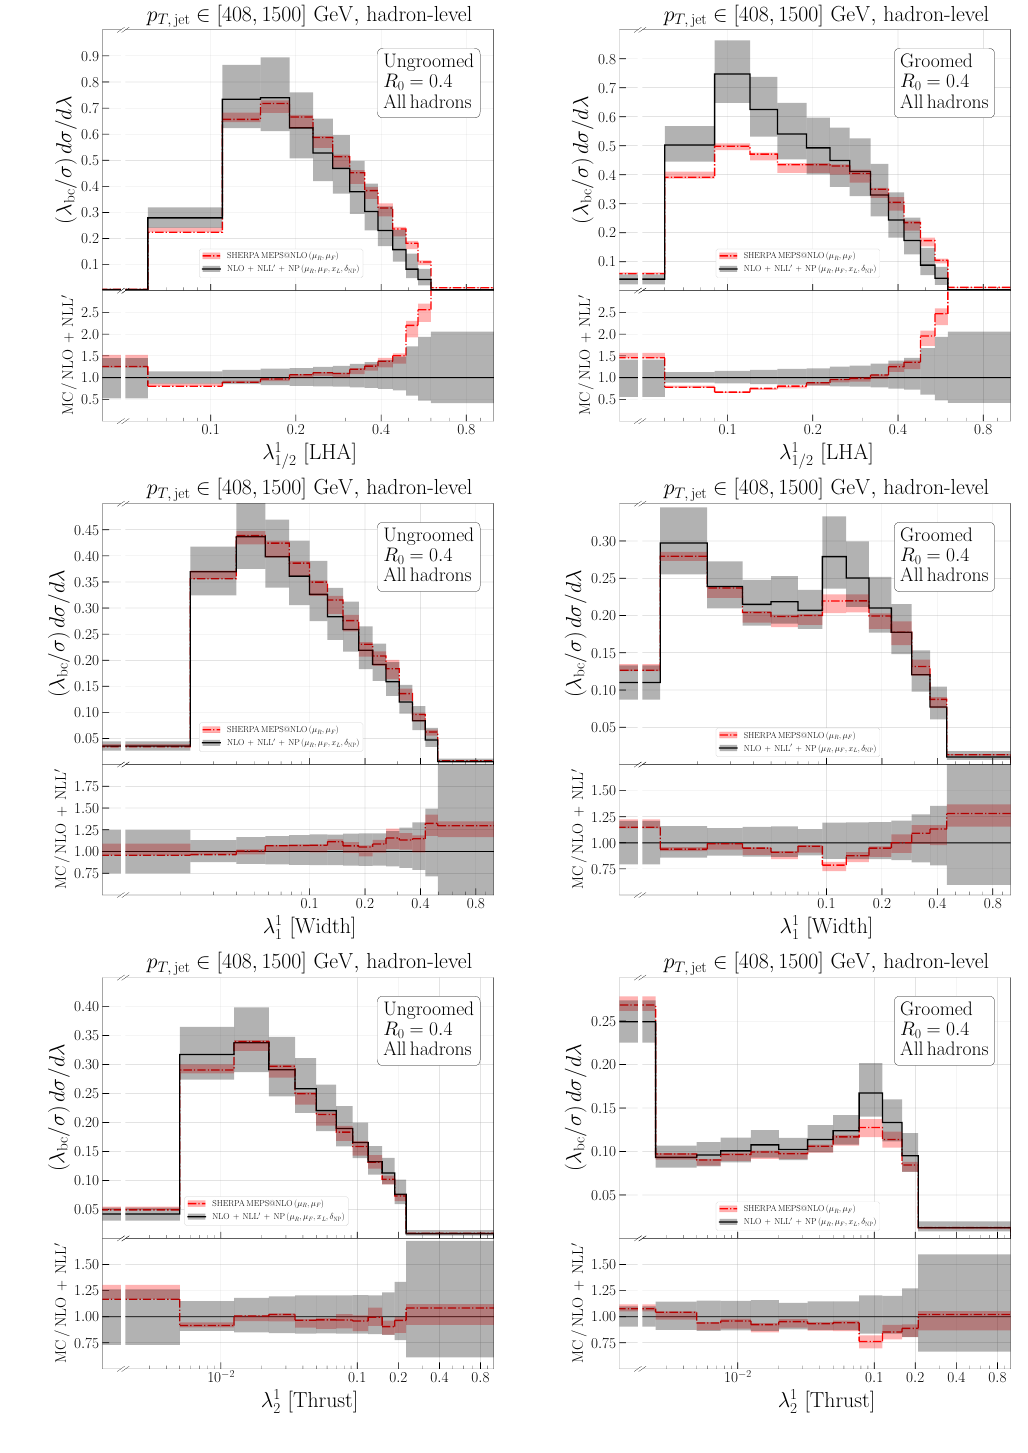
Figure 19 . Same as figure 14 but for R 0 = 0 . 4